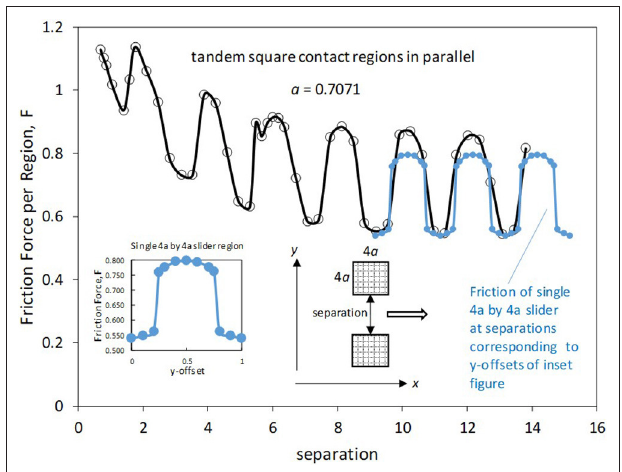
FIGURE 13 | Friction force vs. inter-slider separation for separation along y- axis. Inset shows the effect of slider offset for an isolated